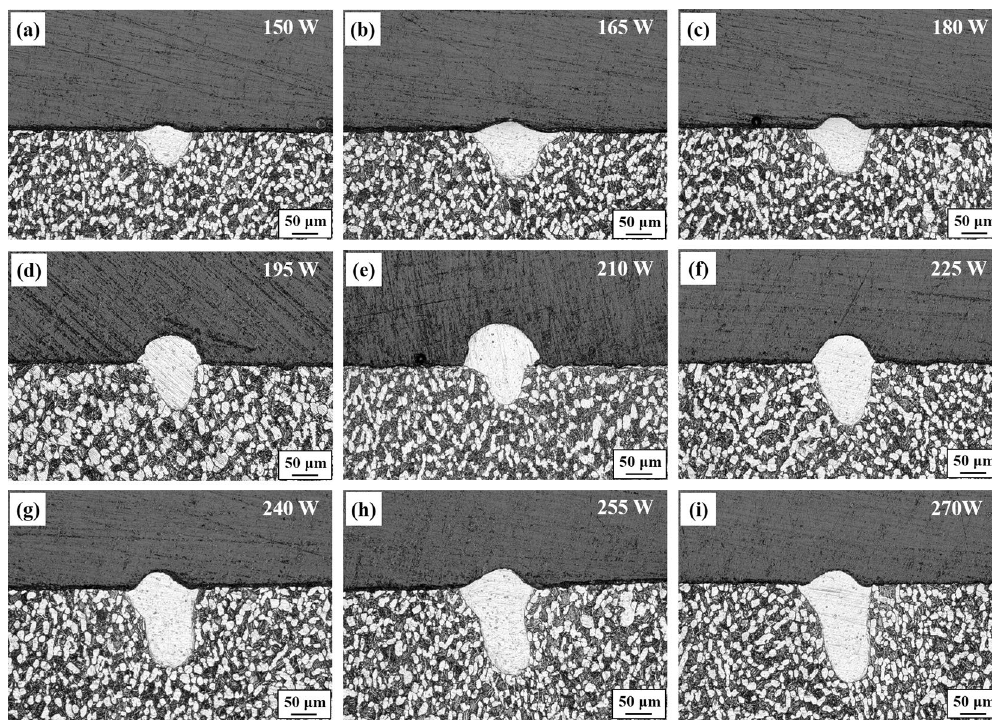
Figure 6 Cross-sectional of LPBF tracks at v